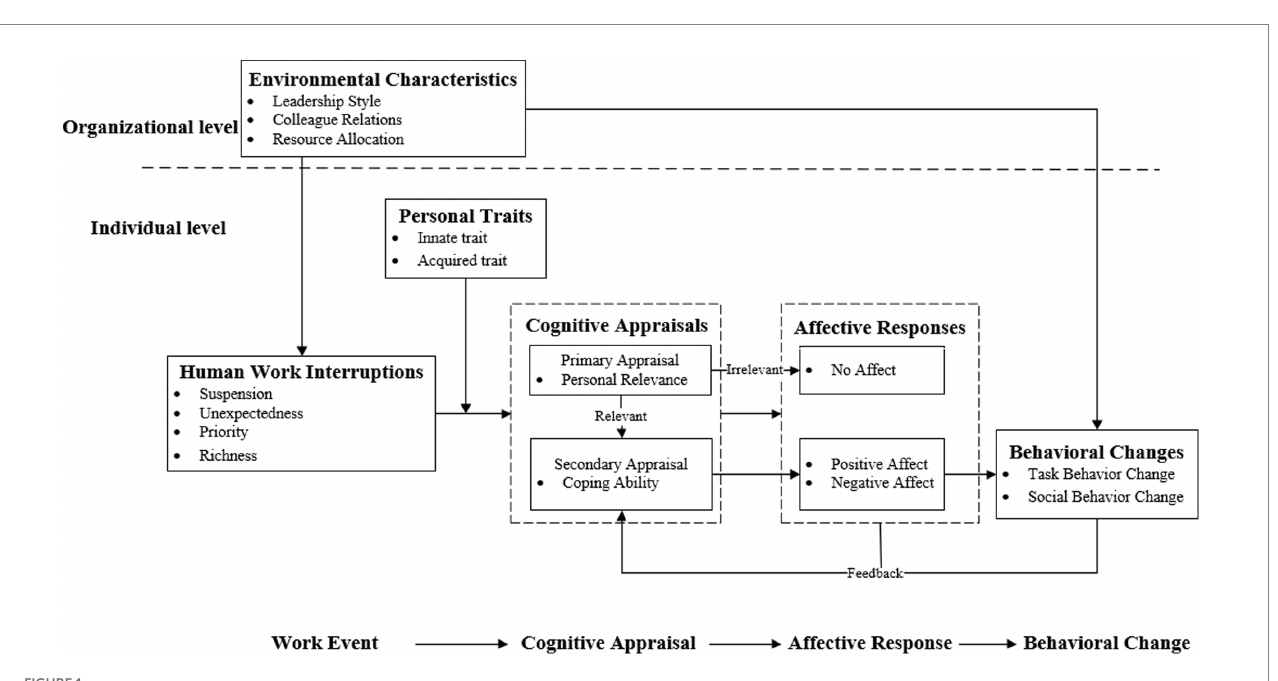
FIGURE 1 Human work interruptions–cognitive appraisals–affect responses–behavioral changes model.